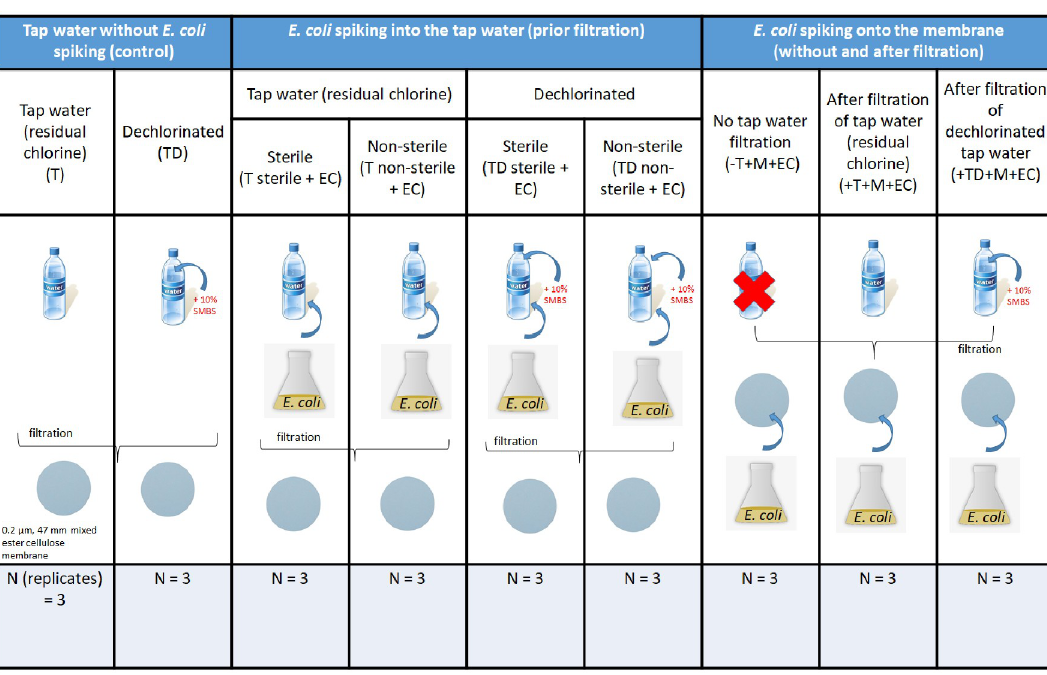
Fig 2. Scheme of the batch experiments for evaluating DNA extraction yield via addition of E . coli cell solution. The experiments were designed with three main scenarios: Tap water without E . coli spiking, tap water with E . coli spiking prior filtration, membrane spiking with E . coli without and after tap water filtration; and sub-scenarios (T: Tap water with residual chlorine, TD: Dechlorinated tap water, sterile: Tap water was pre-sterilized with membrane filtration to remove indigenous microbes, non-sterile: Tap water with no prior pre-filtration). Each replicate (n) comprises of four liters of tap water. Each treatment is explicitly assigned with the code shown at the second row of the table. Sterile mixed ester cellulose membrane filter (0.2 μ m, 47 mm diameter) was used for tap water filtration (i.e., biomass collection). A 100 μ L of 10% (v/v) solution sodium metabisulfite (SMBS) (Na 2 S 2 O 5 ) was used as the dechlorinating